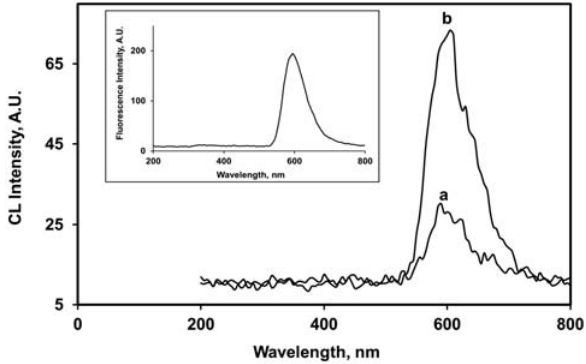
Figure 7. CL spectra of a) Ru(phen) 32+ -Ce(IV) b) Ru(phen) 32+ - Ce(IV)-mepivacaine. Conditions: 200 μL mepivacaine (226.25 μg mL –1 ), 1 mL Ru(phen) 32+ ( 3.0 × 10 –3 mol L –1 ), 0.5 mL Ce(IV) (5.0 × 10 –3 mol L –1 in 0.1 mol L –1 of H ( λ = 325 nm) of Ru(phen) 32+ at 595 ex